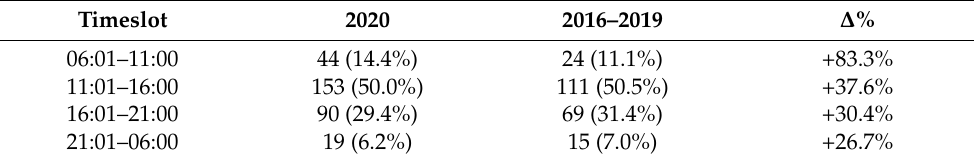
Table 4. Frequency of rescues for different timeslots.